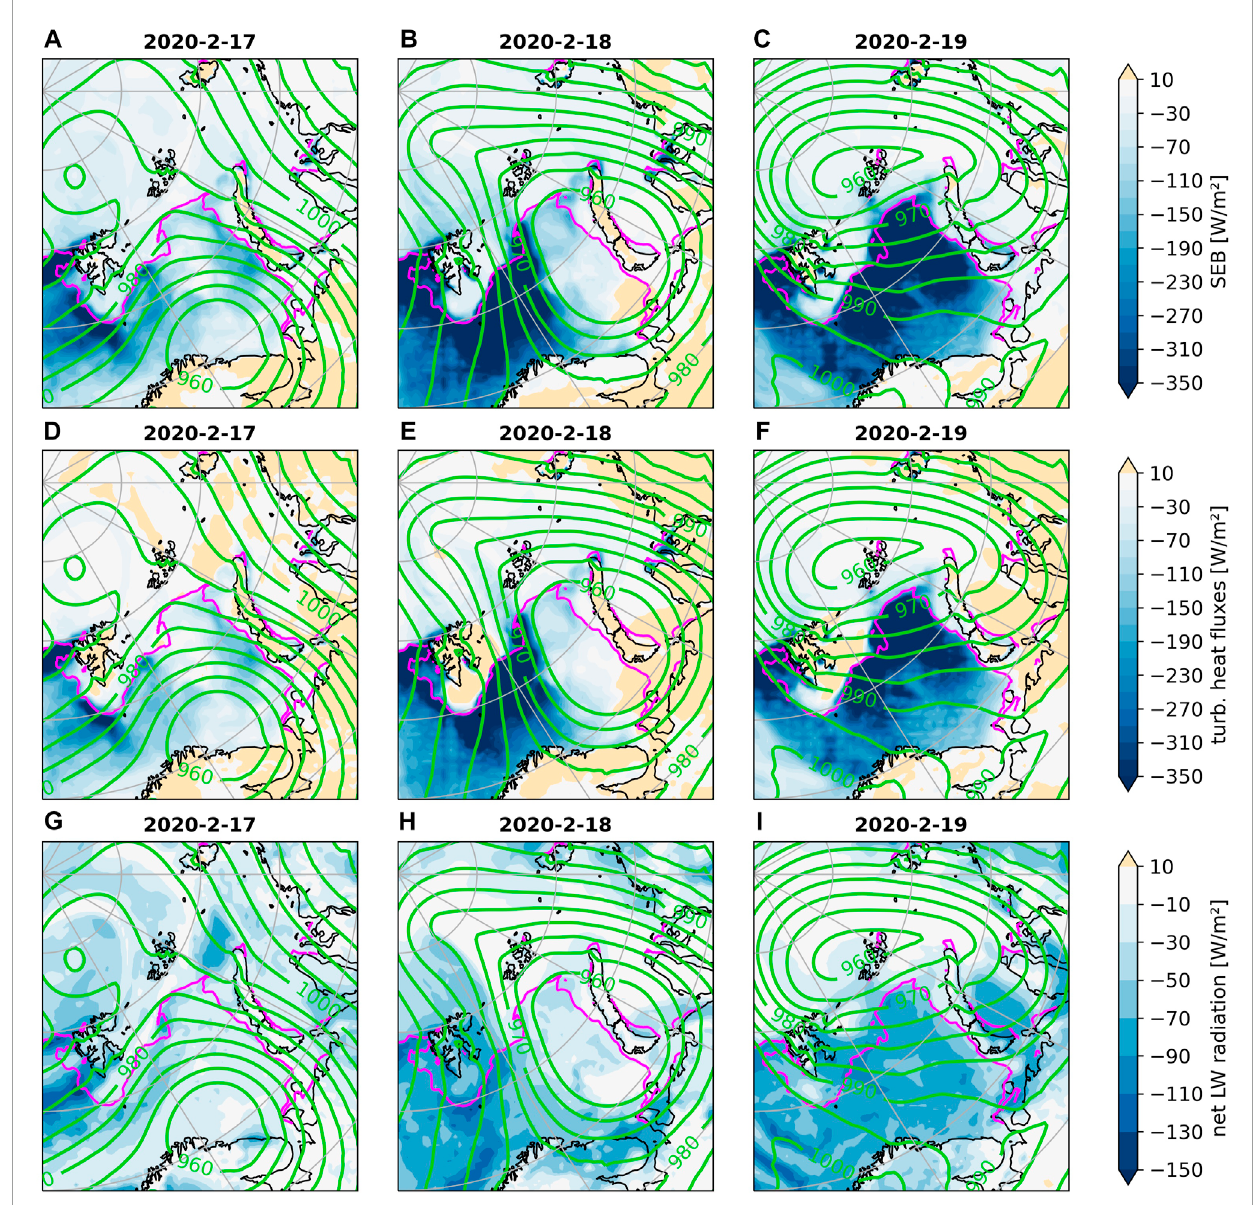
FIGURE 3 Daily means of atmospheric surface energy budget (SEB) (A–C) , sum of atmospheric turbulent surface heat fluxes (D–F) and net longwave radiation (G–I) during cyclone 2 (17.2.20—19.2.20) based on the HIRHAM–NAOSIM simulation. Positive (negative) values indicate downward (upward) fluxes. Green contour lines represent daily mean sea level pressure (in steps of 5 hPa); pink lines indicate the position of the ice edge (15%